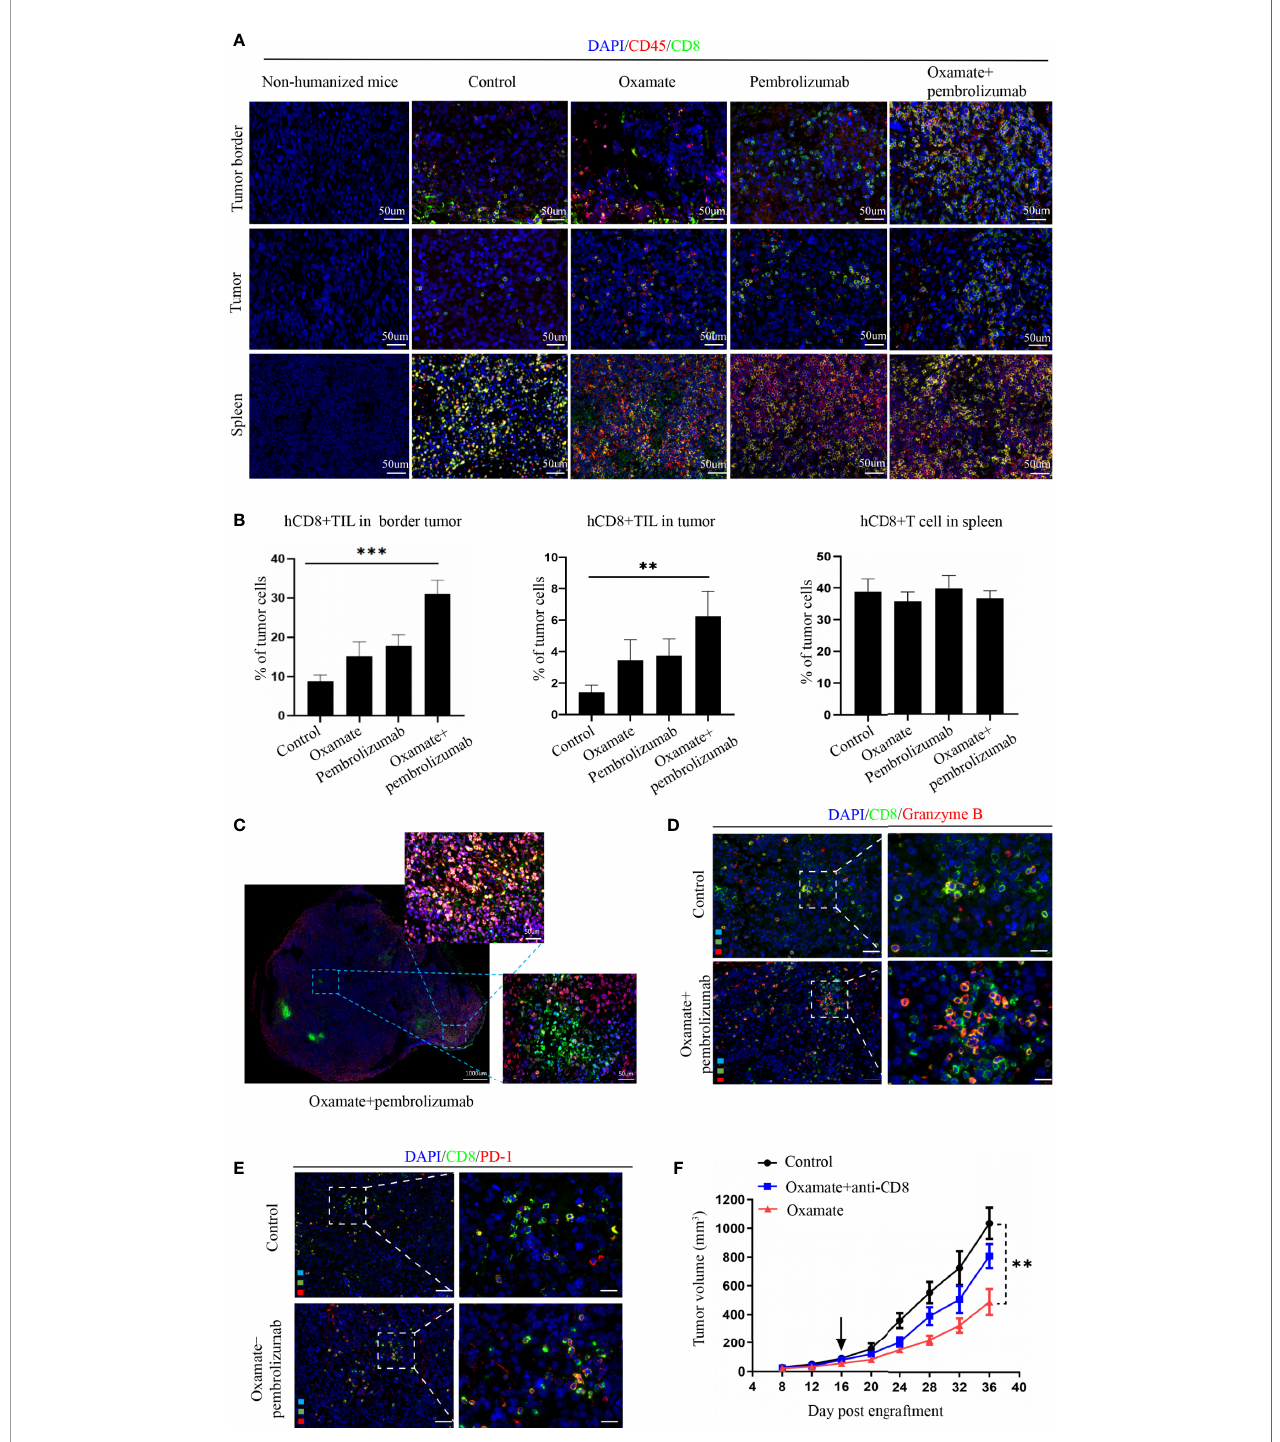
FIGURE 5 | Analysis of tumor immune cell in fi ltration in NSCLC Hu-PBMC-B-NDG mice after treatment. (A) The in fi ltration of CD45+ and CD8+ immuno cells in the spleen and tumours in each treatment group was analyzed by immuno fl uorescence. CD45+(Red) CD8+(Green). (B) Immuno fl uorescence quantitative analysis of CD8+T cells in tumor and spleen of each treatment group. **P<0.01, ***P<0.001. (C) Immuno fl uorescence of a representative CDX after treated with oxamate + pembrolizumab. (D)(E) Immuno fl uorescence was used to analyze the activation of CD8+ cells in the control group and the combined treatment group, and CD8+ Granzyme B + T cells and CD8+ PD-1+ T cells were labeled respectively. (F) Tumour growth curve of Hu-PBMC-CDX treated with oxamate alone or oxamate plus anti-CD8 depletion mAb. Data are presented as the mean ± SD of the volume of CDX (mm 3 ); n = 6.